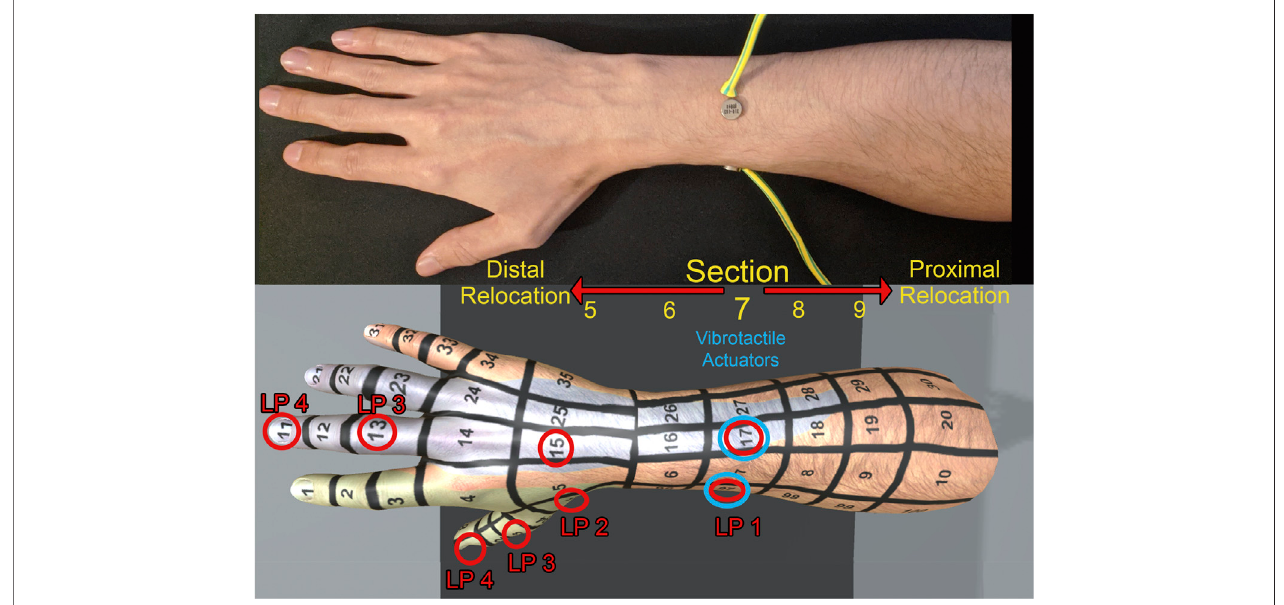
FIGURE1| Physicalset-upofthevibration actuators onthearm (A) withthevirtualfairskinmale armidentifyinglightpositions (B) .Thephysical vibration actuators were placed at section 17 and 97. LP (cid:1) Light position. Positions of the lights are labeled in red and position of the physical vibration actuator labeled in blue. The arm models had a blue and green color map applied which signaled dermatomes and were used for veri fi cation of verbal response.